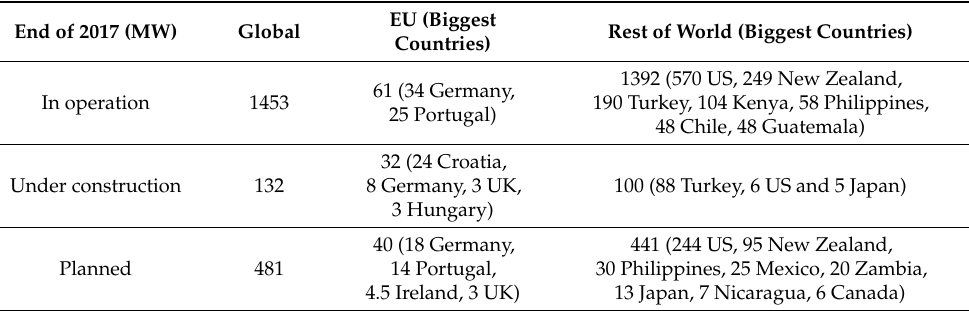
Table 3. Installed binary ORC geothermal power plants (based on [49]).